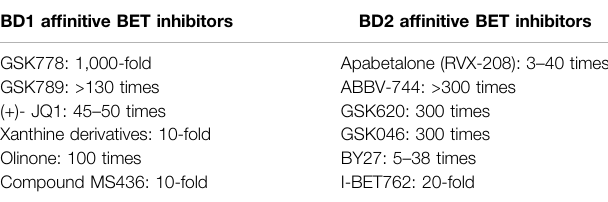
TABLE1| Examplesofsomebromodomainandextraterminal(BET)inhibitorsand their BD1 or BD2 binding af fi nities over counter BD